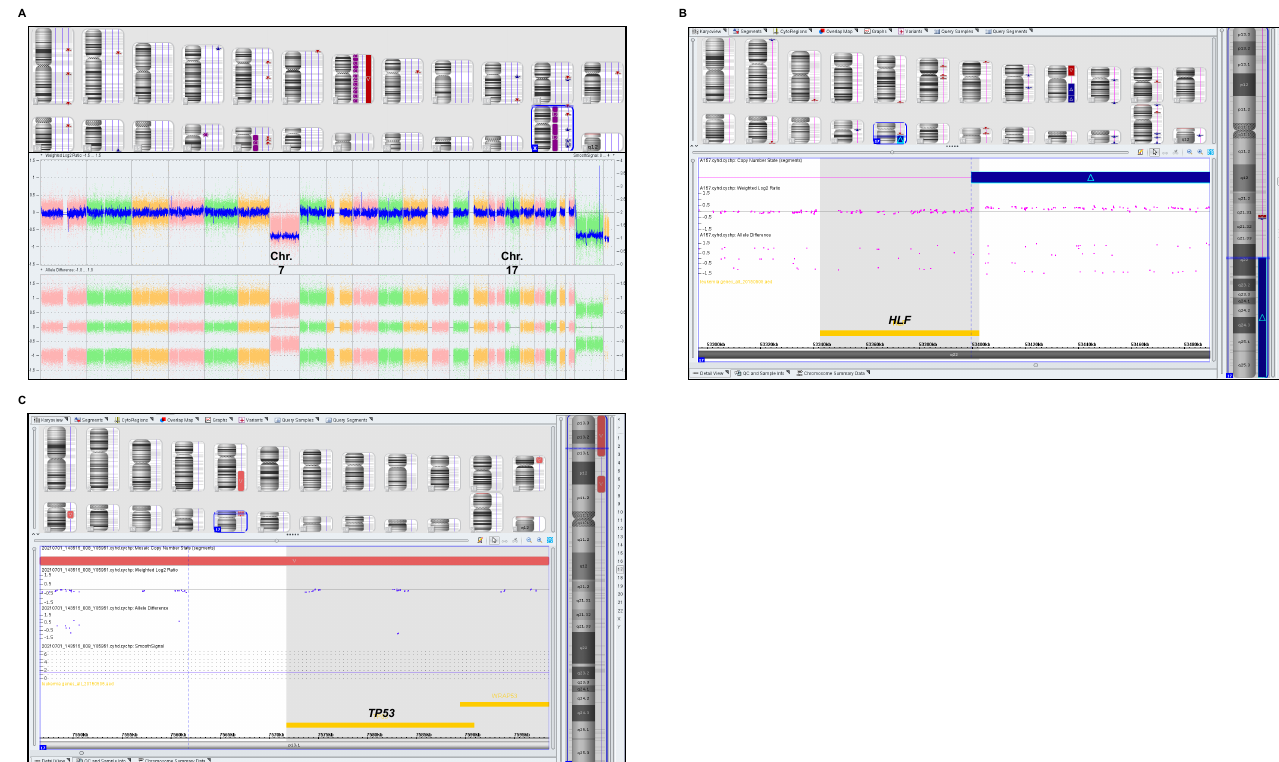
Figure 1. Results of single nucleotide polymorphism array analysis of the leukaemic genomes in selected patients treated with venetoclax. ( A ) Whole genome view showing monosomy 7 and LOH of chromosome 17q in patient 1. ( B ) Chromosomal microarray analysis data plot for chromosome 17 displaying the gain of 17q22–q25.3, which involves exon 4 of the HLF gene in patient 2. ( C ) CMA data plot showing the 17p13.1–p13.3 deletion encompassing the TP53 gene in patient 3. Copy number abnormalities were identified by a decrease (deletion) or an increase (gain) in the Log2 ratio. The coordinates are in reference to GRCh37/hg19.